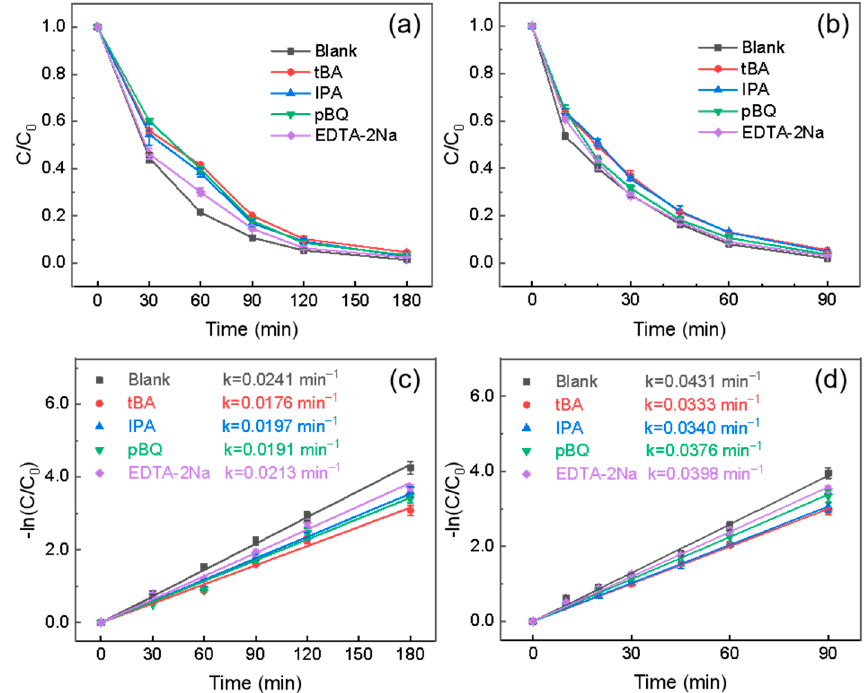
Figure 6. The concentration curves of ( a ) SMX and ( b ) ENR in their photodegradation after adding several quenchers, and kinetic curves of ( c ) SMX and ( d ) ENR photodegradation.